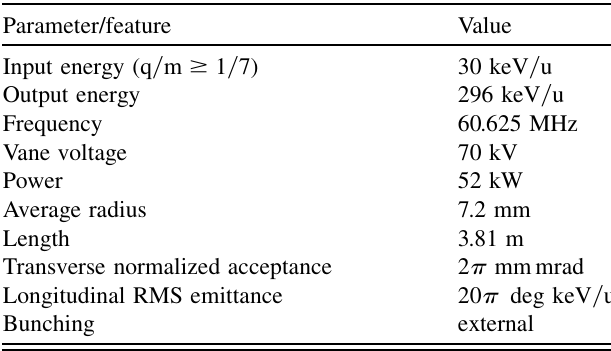
TABLE IV. Main parameters of the ATLAS upgrade RFQ. Parameter/feature